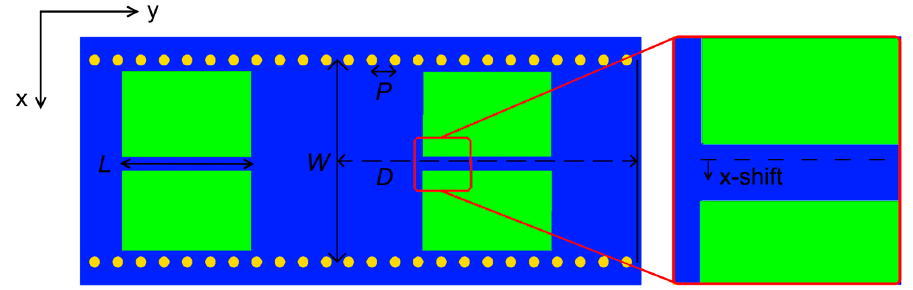
Figure 1. Top view of the proposed periodic substrate-integrated waveguide (SIW) leaky-wave antenna (LWA) design based on a printed circuit board (PCB) with top metallization (blue) and dielectric (green), where W denotes the 2.6 mm width of the SIW, P the 0.3 mm pitch of the via holes (yellow) with 0.15 mm diameter and D the 3.9 mm periodicity of the array.